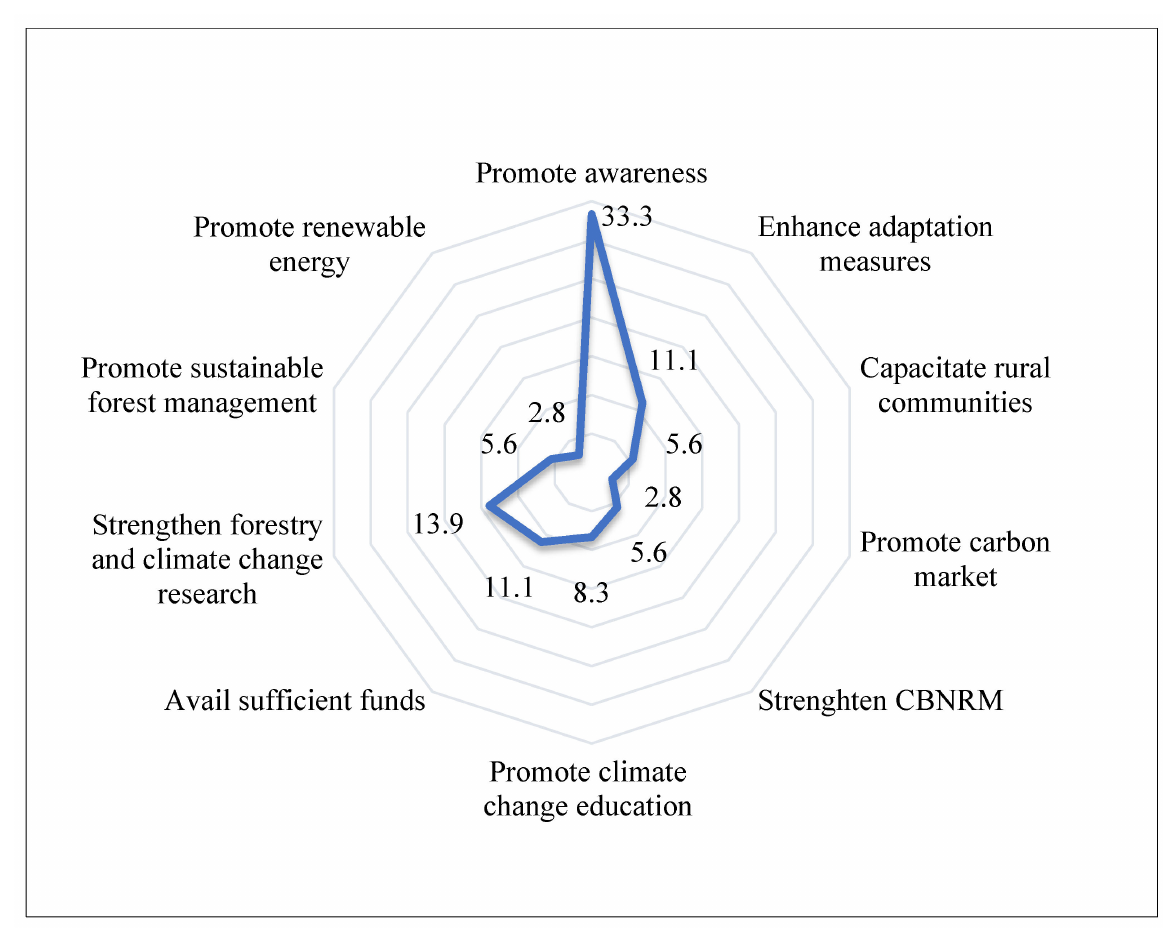
Figure 3. Proposed improvements in the implementation of the NPCC, according to the experts. Proposed improvements for the NPCC are presented as